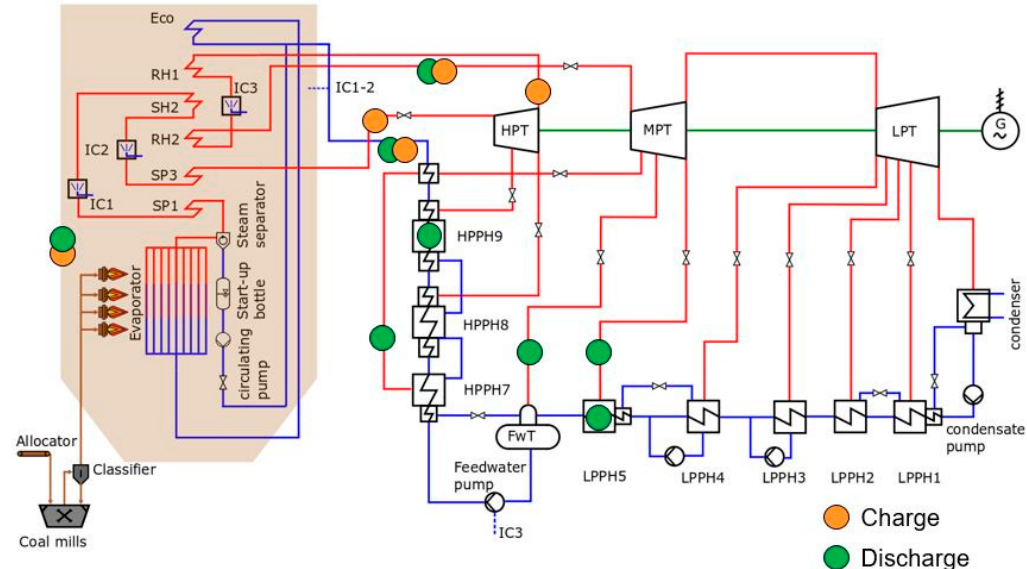
Figure 3. Thermal circuit diagram of the stationary power plant model with charging and discharging points of all storage concepts considered in the first project phase (Eco = Economizer, FwT = Feedwatertank, G = Generator, HPT = High Pressure Turbine, HPPH = High Pressure Preheater, IC = Intercooler, LPPH = Low Pressure Preheater, LPT = Low Pressure Turbine, MPT = Medium Pressure Turbine, RH = Reheater, SH = Superheater, SP = Steam